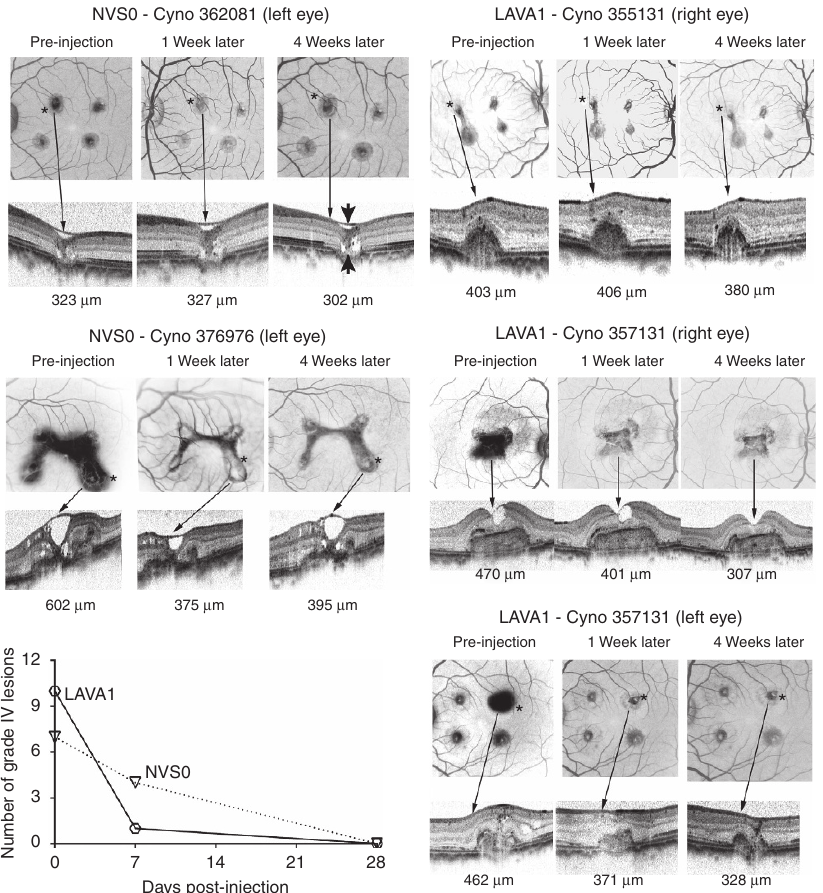
Figure 3 | Efficacy of NVS0 and LAVA1 in the cynomolgus monkey laser-CNV model. CNV lesions were induced 4–9 months before dosing. Representative images of cynomolgus monkey eyes injected with NVS0 or LAVA1. The fundus images are shown as negatives (black and white reversed) to highlight the vascular leakage of fluorescein during fluorescein angiography. Each eye received four laser burns producing neovascular tufts (CNV) that appear as dark spots in the images; the darkness corresponds to the degree of vascular leakage from the lesions. The asterisks ‘*’ in the fundus images correspond to the lesion from which retinal thickness was measured by optical coherence tomography (OCT). Total retinal thickness (values shown in the bottom of each OCTscan) was measured at the center of the lesion using calipers provided in the Spectralis software as the distance between the inner limiting membrane and retinal pigment epithelium (RPE) as shown by the arrow heads in the OCT of 362081 left eye. Both NVS0 and LAVA1 markedly reduced CNV-induced retinal oedema within 4 weeks. The plot shows the number of grade IV lesions at the time of dosing, 1 week and 4 weeks post dosing with NVS0 or LAVA1. Both NVS0 and LAVA1 reduced the number of grade IV lesions and retinal oedema within 4 weeks of